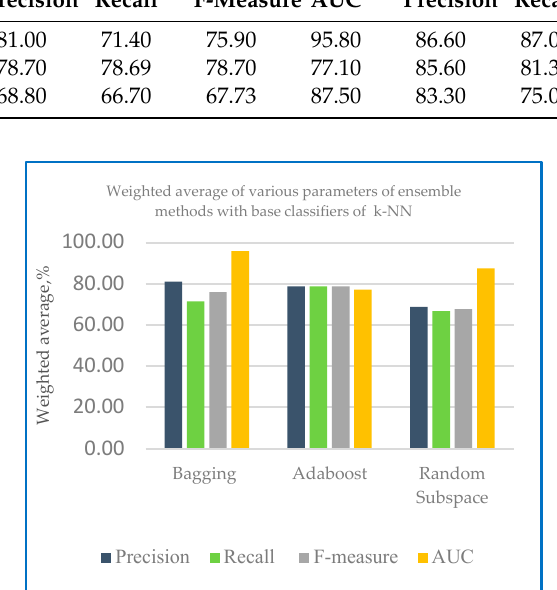
Figure 7. Weighted average of various parameters of ensemble methods with base classifiers of k-NN.